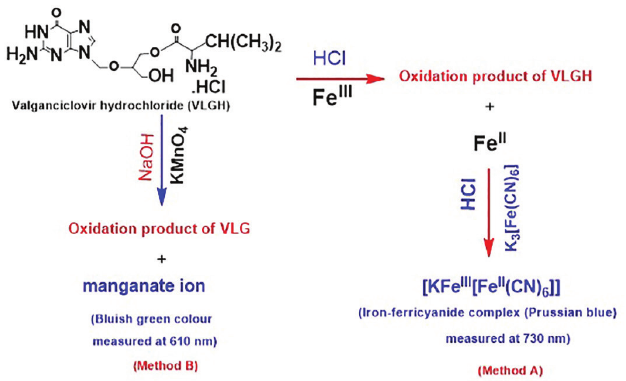
FIGURE 2 - Absorption spectra of: (a) Manganate ion (method B) [20 µg mL -1 VLGH]; (b) Prussian blue (method A) [12.5 µg mL -1 VLGH]; c and d are the respective blanks.